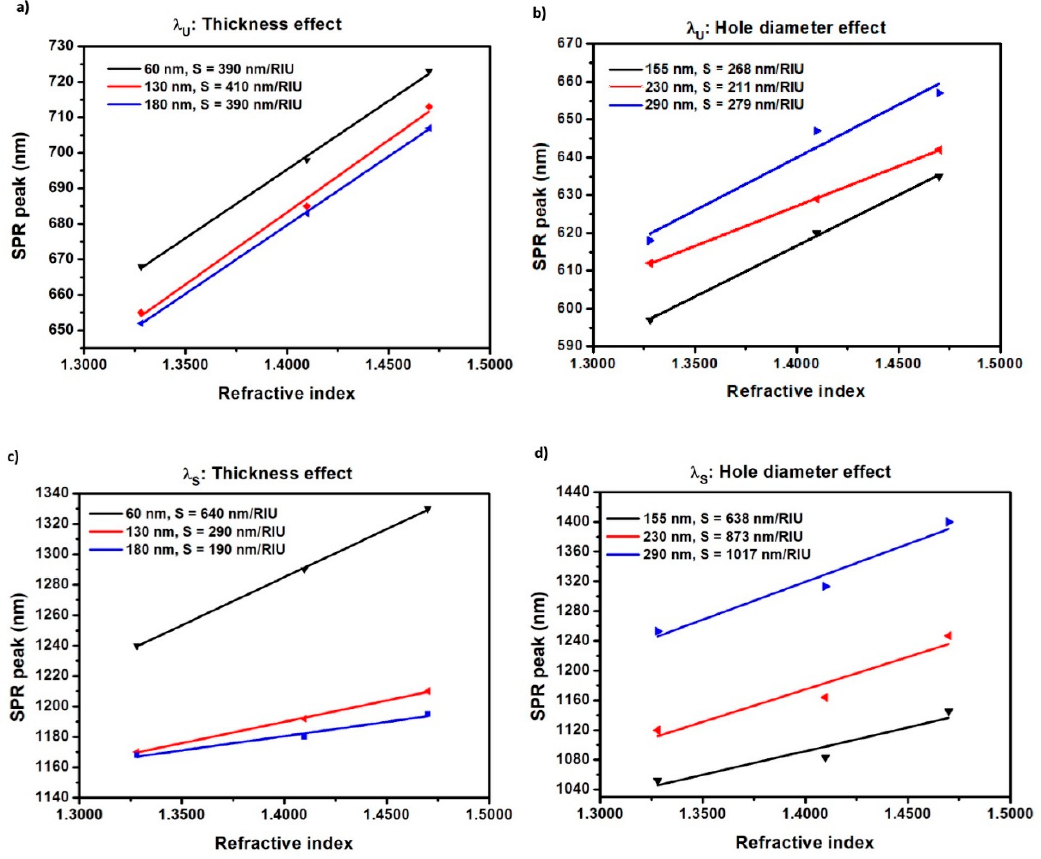
Figure 7. SPR peak position corresponding to λ u and λ s as a function of refractive index for di ff erent film thickness and diameters of the fabricated nanohole arrays ( a ) sensitivity variation for λ u in samples with di ff erent thicknesses ( Λ : 675 nm, D: 280 nm); ( b ) sensitivity variation for λ u in samples with di ff erent diameters ( Λ : 575 nm, t: 60 nm); ( c ) sensitivity variation for λ s in samples with di ff erent thicknesses ( Λ : 675 nm, D: 280 nm), and ( d ) sensitivity variation for λ s in samples with di ff erent diameters ( Λ : 575nm, t: 60nm).